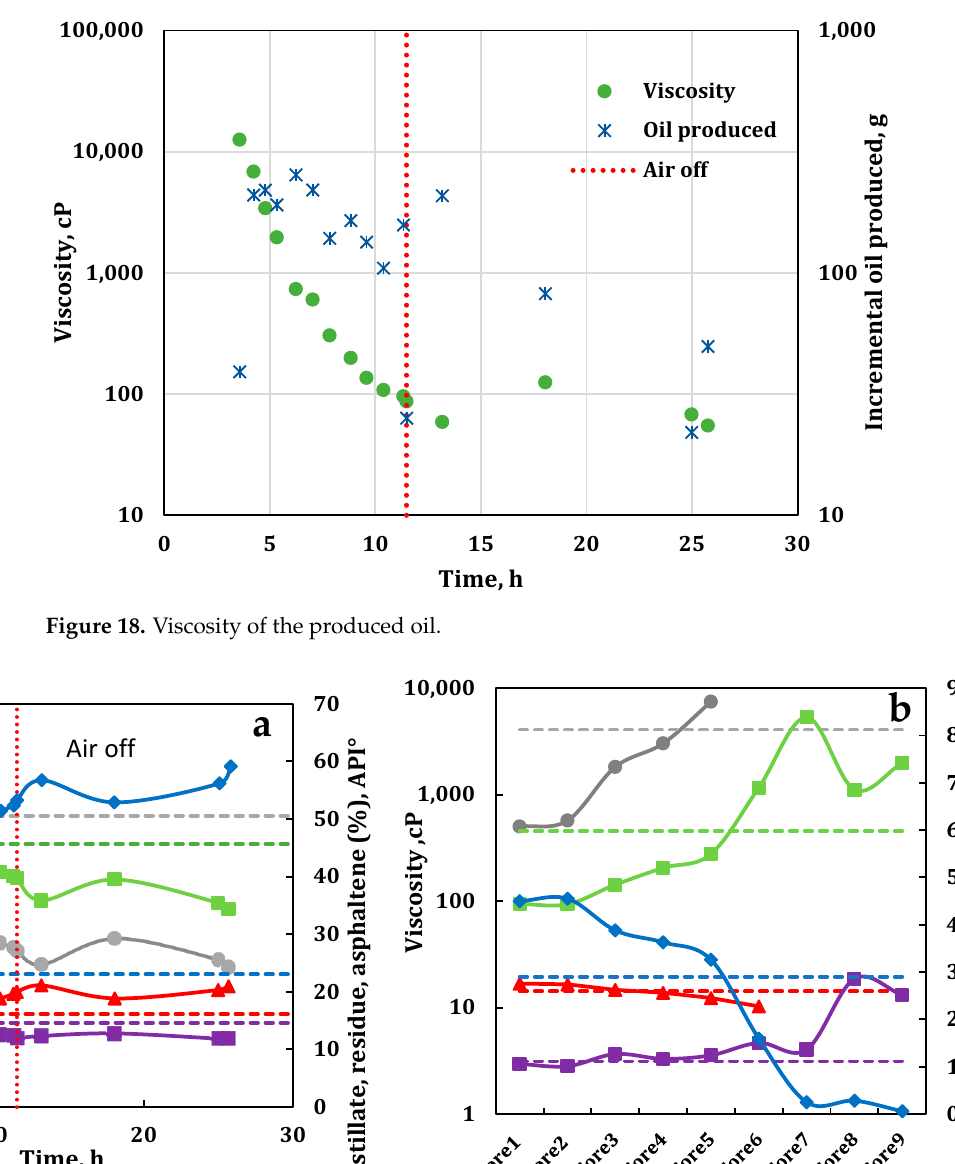
operation. Thus, the viscosity varied from 4091 to 59 cP (measured at 25 ◦ C), with the trend decreasing as the produced oil samples corresponding to the combustion front approached the production outlet.